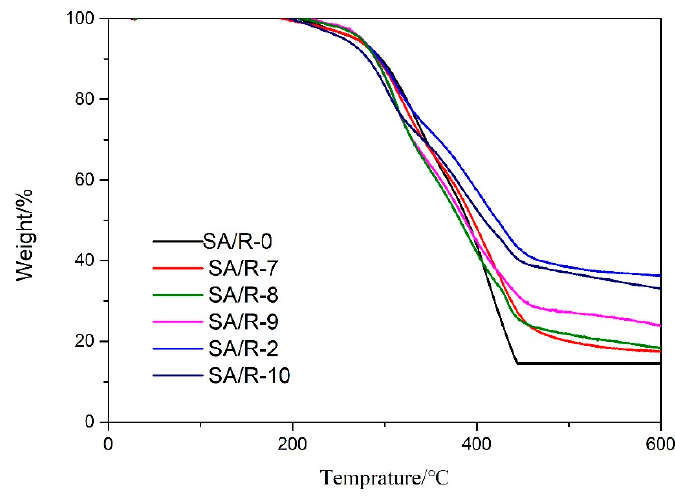
Figure 5. TG curves of silica aerogel/resin composites with different contents of silica aerogel. 2.4. Effect of Silica Aerogel on the Mechanical Properties of Silica Aerogel/Resin Composites The short life span of dental restorative materials is mainly due to stress fractures.